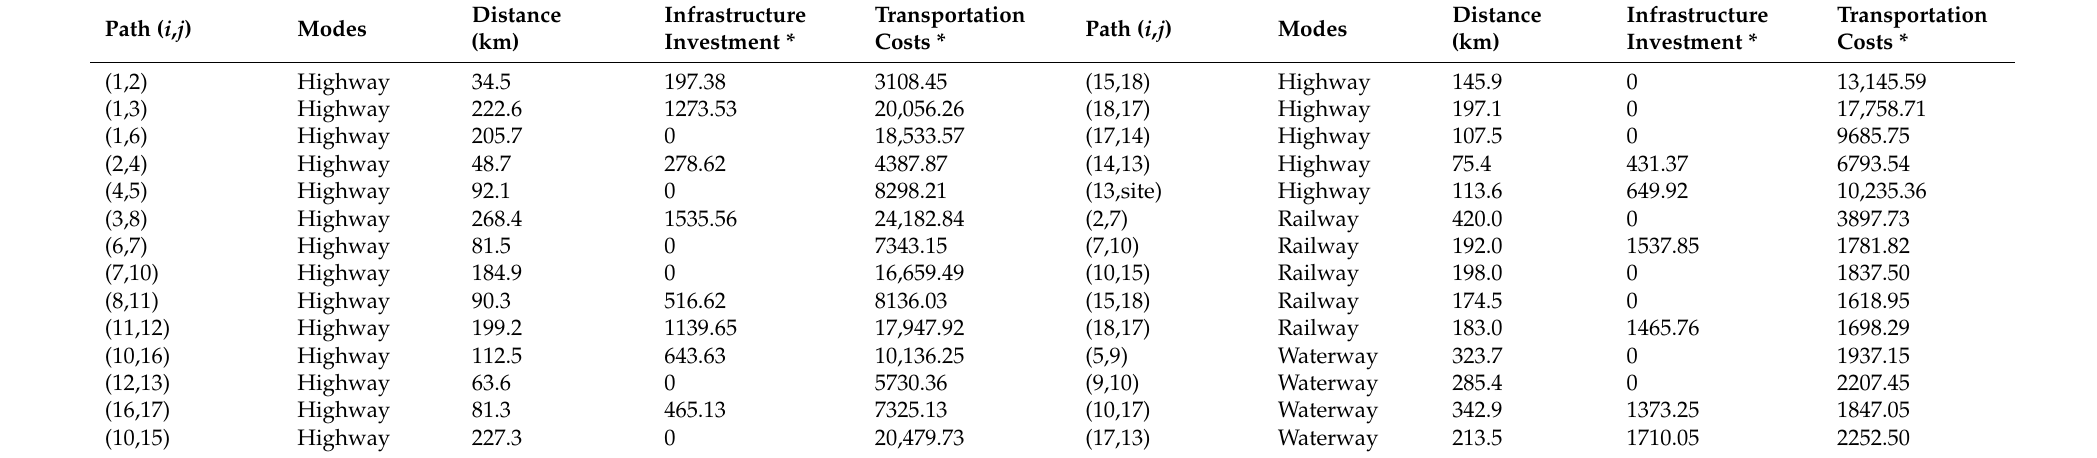
Table 2. The information of each path in the transportation network of the